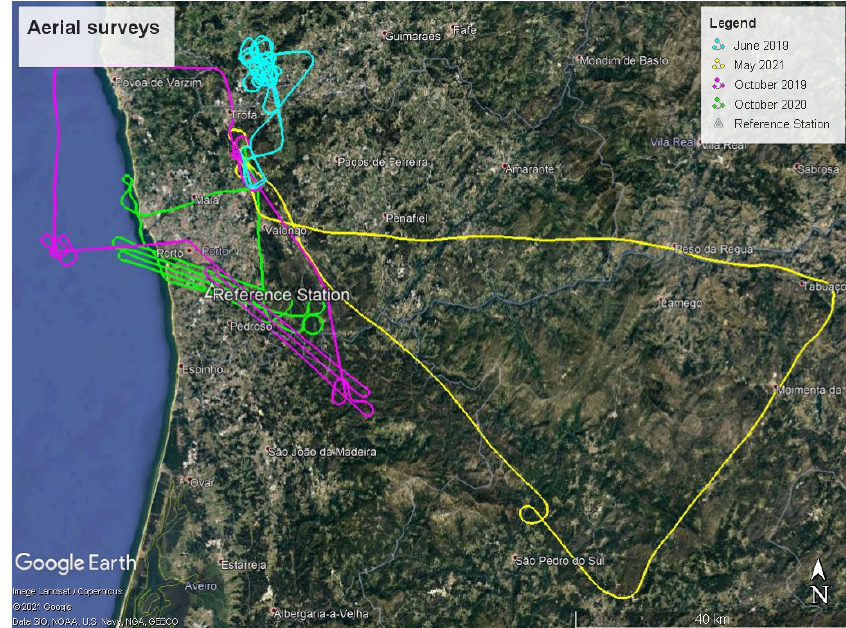
Figure 2. Aircraft trajectories of the four aerial campaigns. Table 5. Equipment used in the aerial data-collection